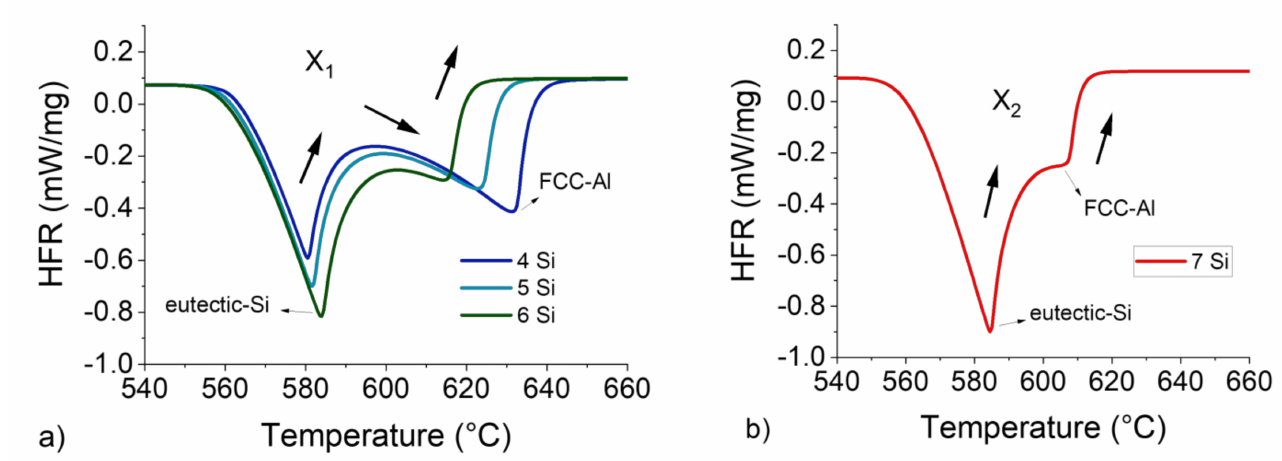
Figure 6. HFR vs. T curves for 4 to 6 wt.%Si with a 5 ◦ C/min heating rate and 200 mg sample mass, complete curvature inversion at the Al- α /Si-eutectic interface X 1 ( a ), and HFR vs. T curve for 7 wt.%Si with a 5 ◦ C/min heating rate and 200 mg sample mass, with incomplete curvature X 2 ( b ).